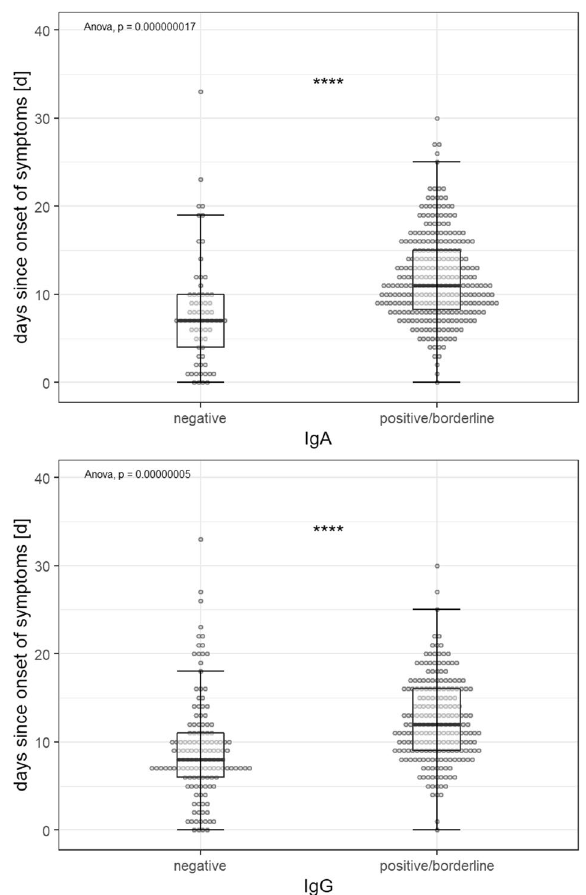
Figure 3. Comparison of the mean amount of days from symptom onset until sample collection between negative and borderline/positive samples for IgA (top) and IgG (bottom).